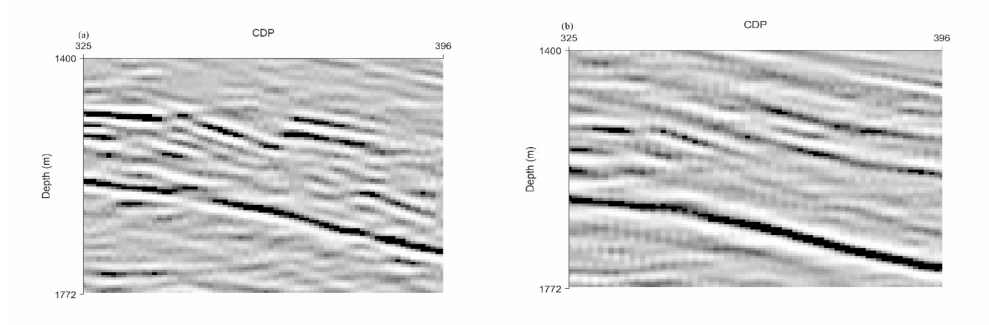
Figure 7. Details of the green dashed box (in Figure 5) using different kinds of waves: ( a ) primary wave; and ( b ) multiple